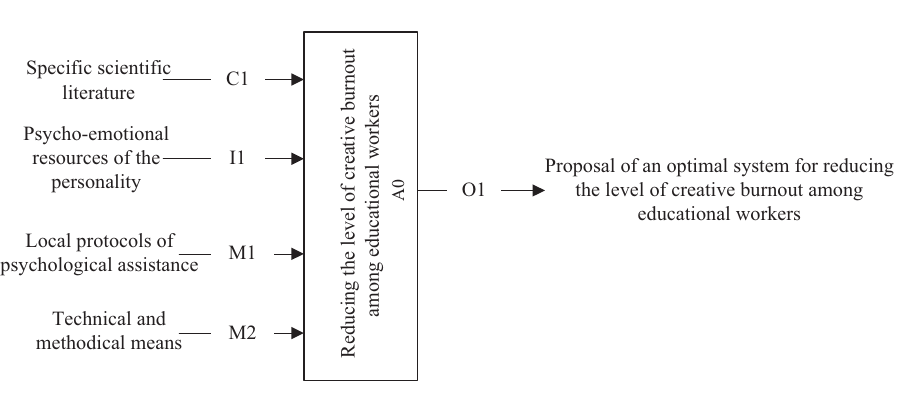
Figure 2. Complex diagram of the IDEF0 model reducing the level of creative burnout (source: created by authors)